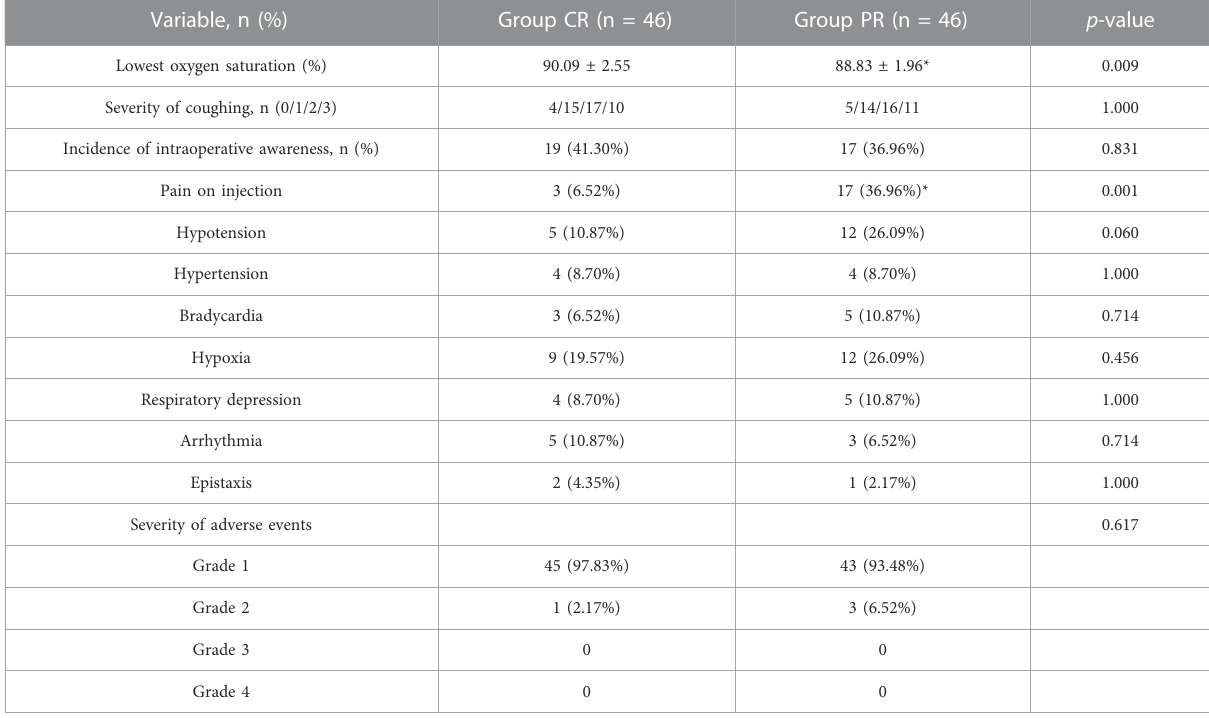
TABLE 4 The Safety parameters between two